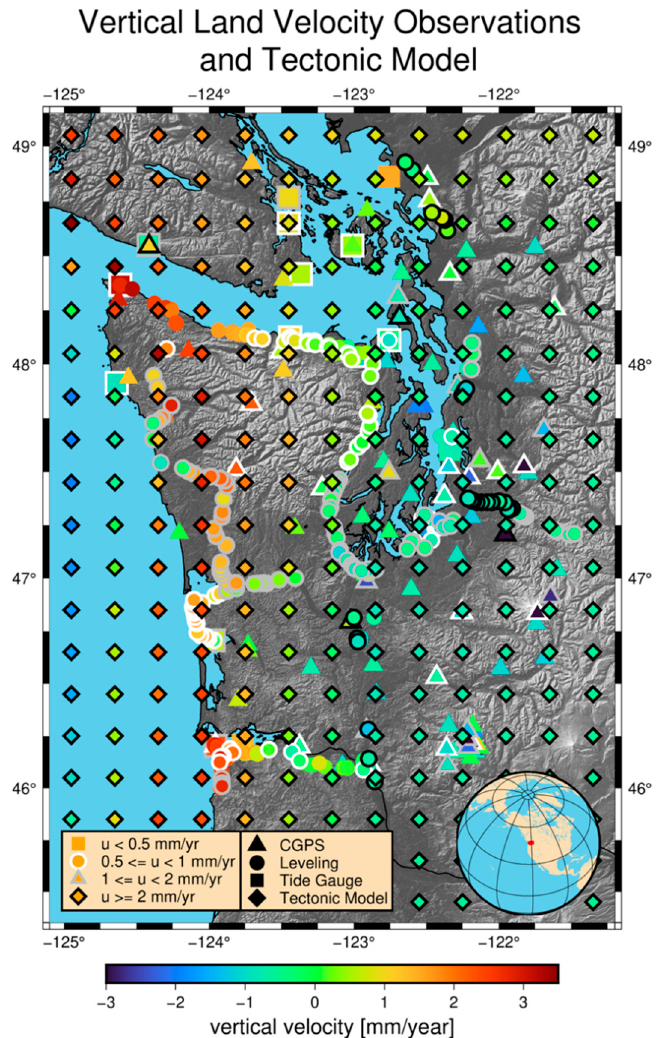
Figure 4. Vertical rate estimates extracted from the tectonic model (Data S1), and measurements of vertical land movement derived from CGNSS, leveling, and tide gauges (Data S2). Data type is denoted by marker shape, vertical velocity is de- noted by marker color, and uncertainty is denoted by marker outline, expressed as millimeters per year (mm/yr). We prescribed a conservative uncertainty of 2 mm/year to estimates from the tectonic model. Note the numerous stretches of coastline without VLM measurements. Refer to Figure 2 for place names. North is up.